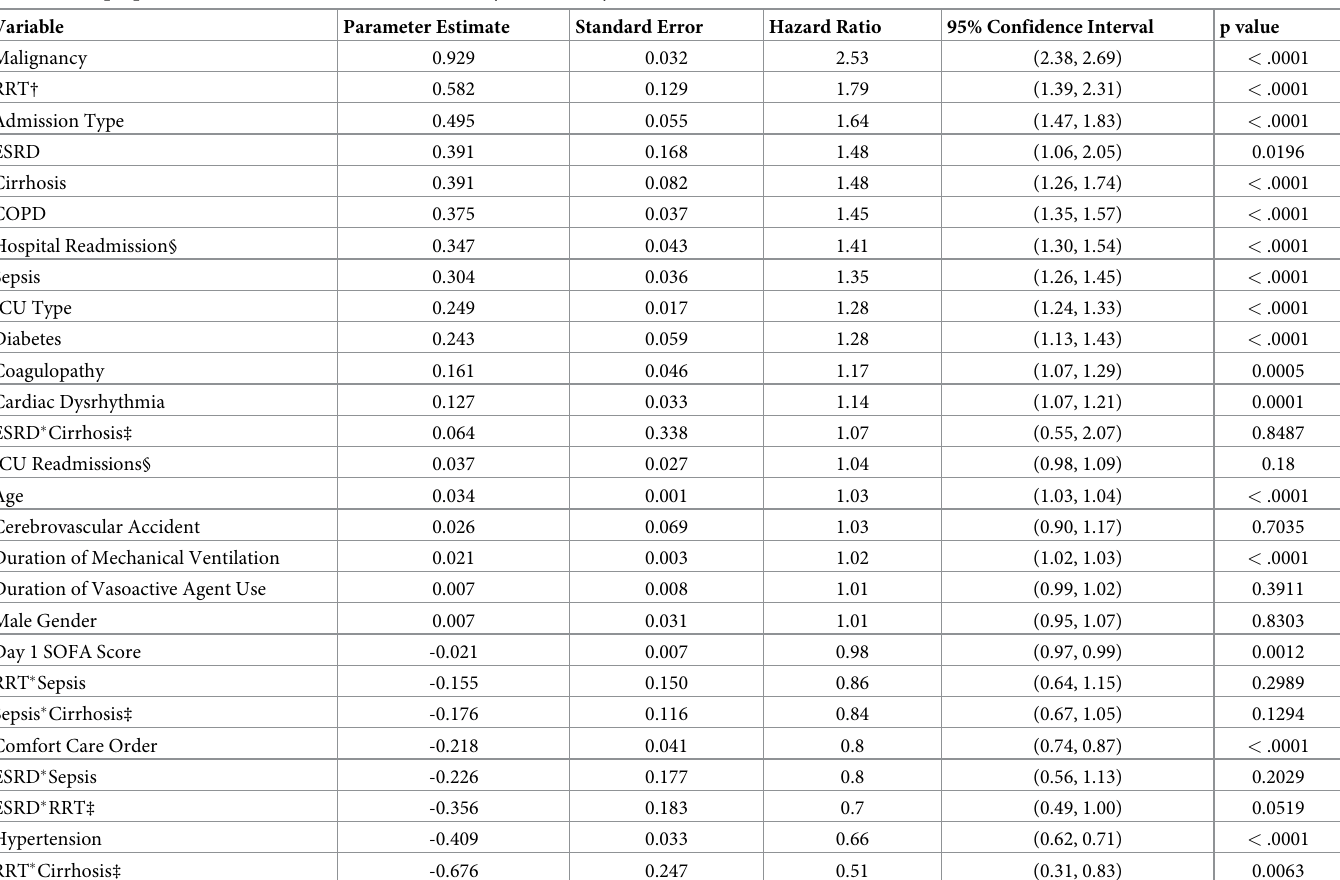
Table 2. Cox proportional hazards model for outcome: One-year mortality (cid:3)